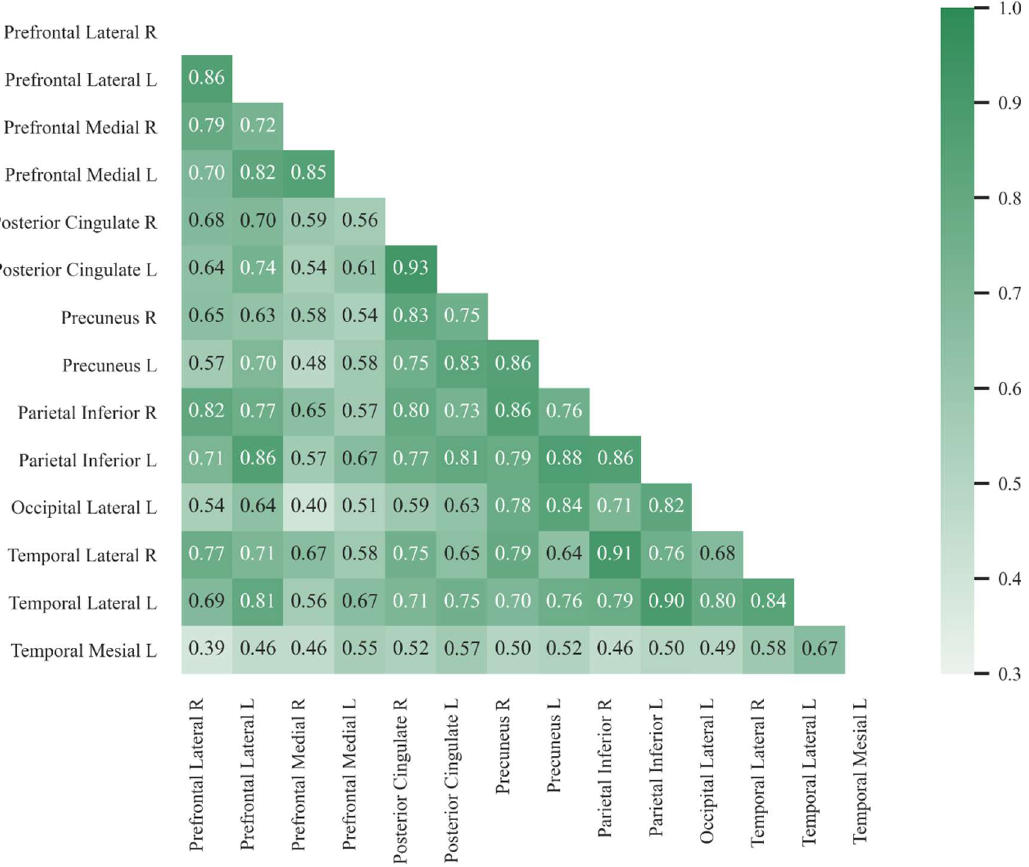
Figure 4. Correlation heat-map. Values report Pearson’s correlation coefficient ( r ) between the z scores from each pair of areas.